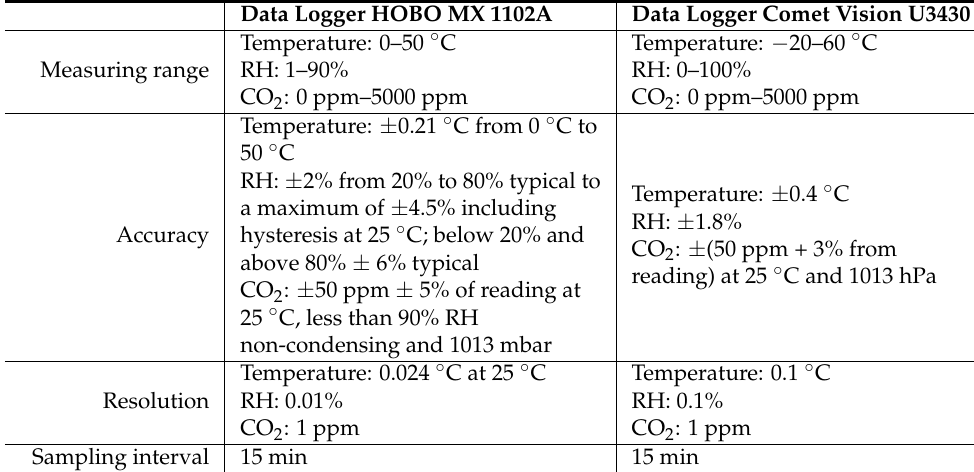
Table 2. CO 2 , temperature and relative humidity (RH) monitoring equipment used in the